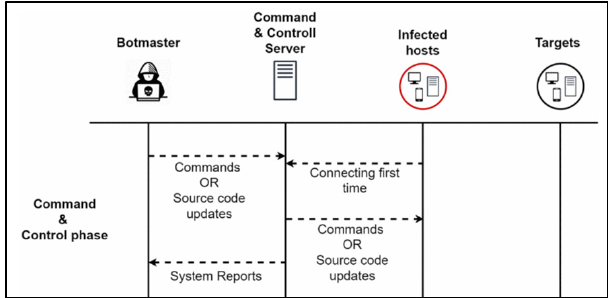
Figure 1. C&C Communication phases.